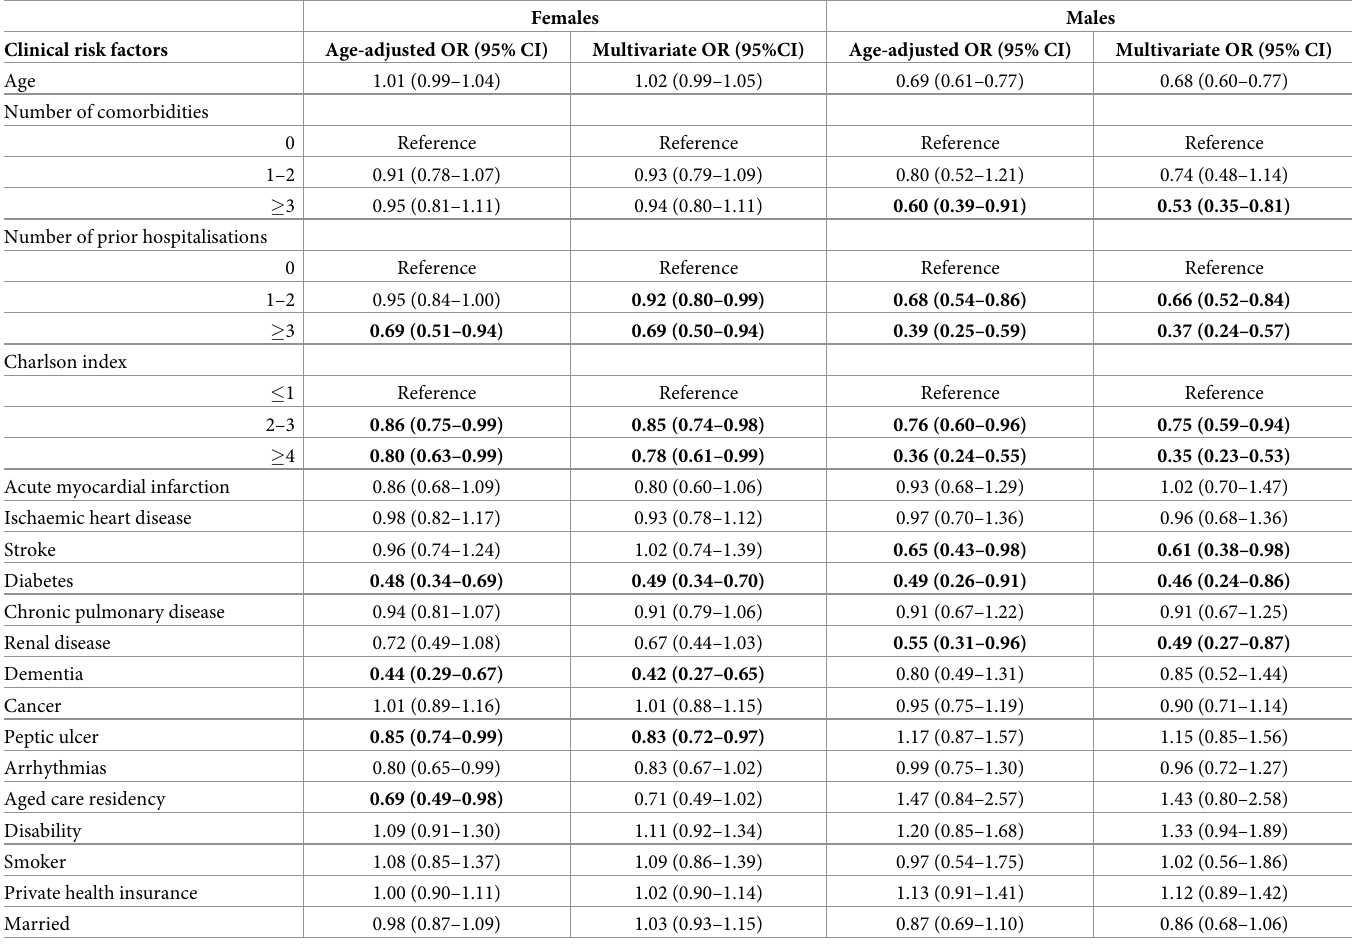
Table 3. Clinical risk factors associated with osteoporosis treatment initiation following index fracture. Females